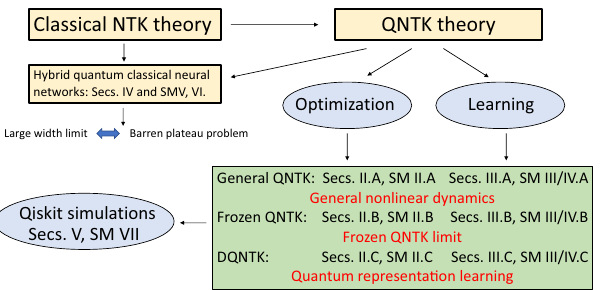
FIG. 2. Structure of our paper. In Sec. II we establish the the- ory of QNTK in the context of optimization without data for generic variational quantum ansatz, which is the typical task in quantum simulation. In Sec. III, we establish the theory of quan- tum machine learning with the help of QNTK. In Sec. IV, we define the hybrid quantum classical neural network model, and we prove that in the large-width limit, the model is